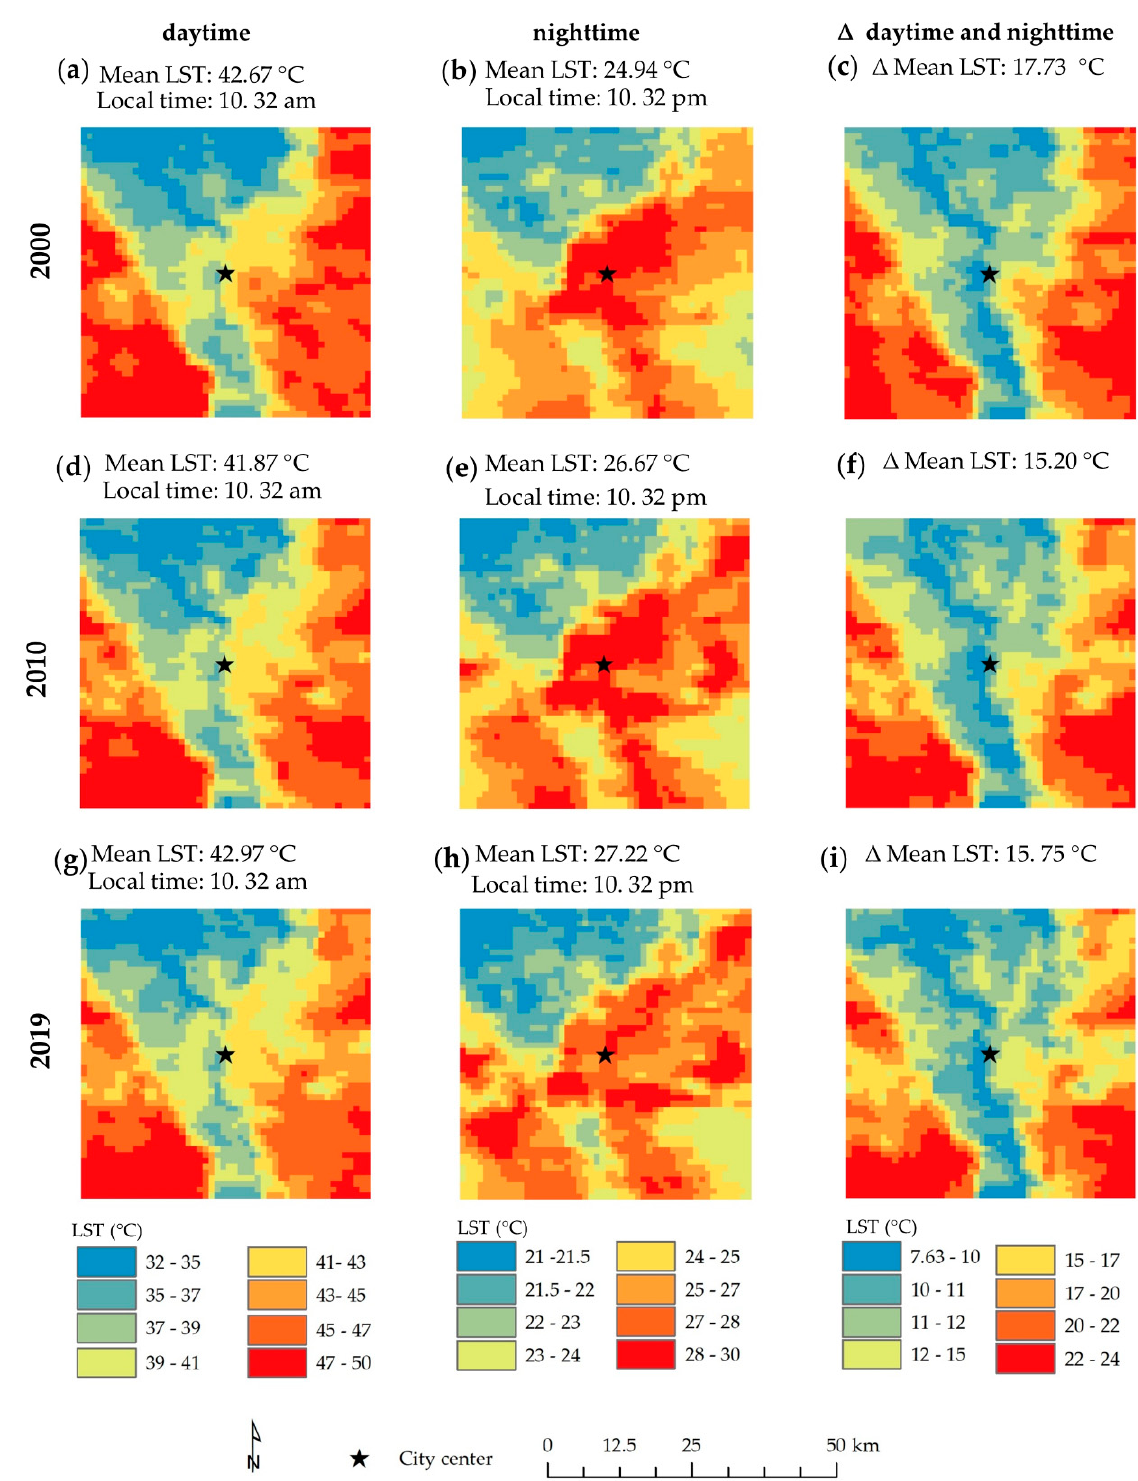
Figure 4. Land surface temperature (LST) maps of Greater Cairo and its environs derived from Moderate Resolution Imaging Spectroradiometer (MODIS) LST data (2000, 2010, and 2019); ( a ) daytime mean LST in 2000; ( b ) nighttime mean LST in 2000; ( c ) daytime and nighttime mean LST difference in 2000; ( d ) daytime mean LST in 2010; ( e ) nighttime mean LST in 2010; ( f ) daytime and nighttime mean LST difference in 2010; ( g ) daytime mean LST in 2019; ( h ) nighttime mean LST in 2019; and ( i ) daytime and nighttime mean LST difference in 2019. The temperatures are the mean clear-sky LST values observed during July and August.